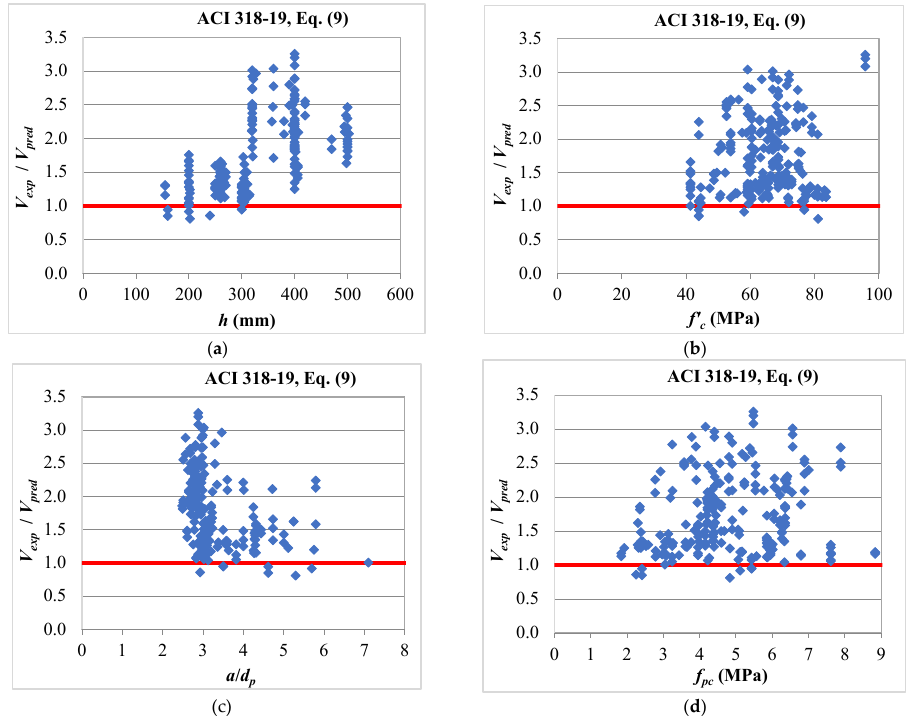
Figure 6. Predictions of the ACI 318-19 design equation against ( a ) total thickness, ( b ) concrete compressive strength, ( c ) shear span to depth ratio, and ( d ) compressive stress due to the fully effective prestressing force.